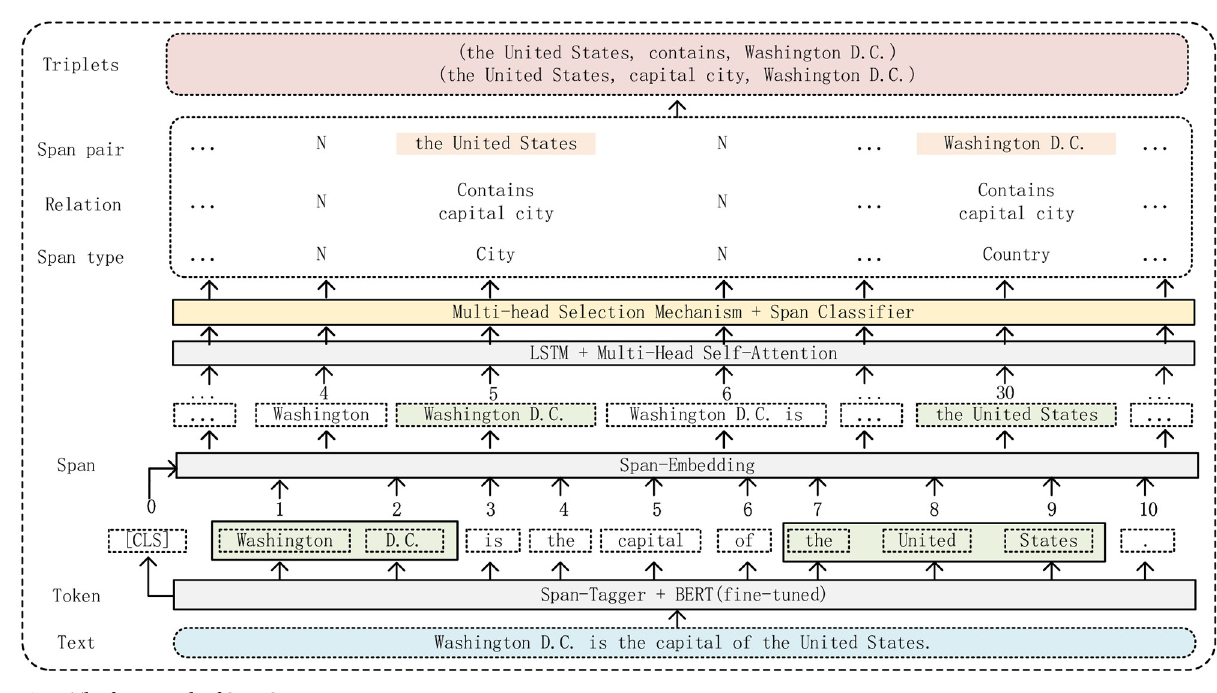
Fig 1. The framework of